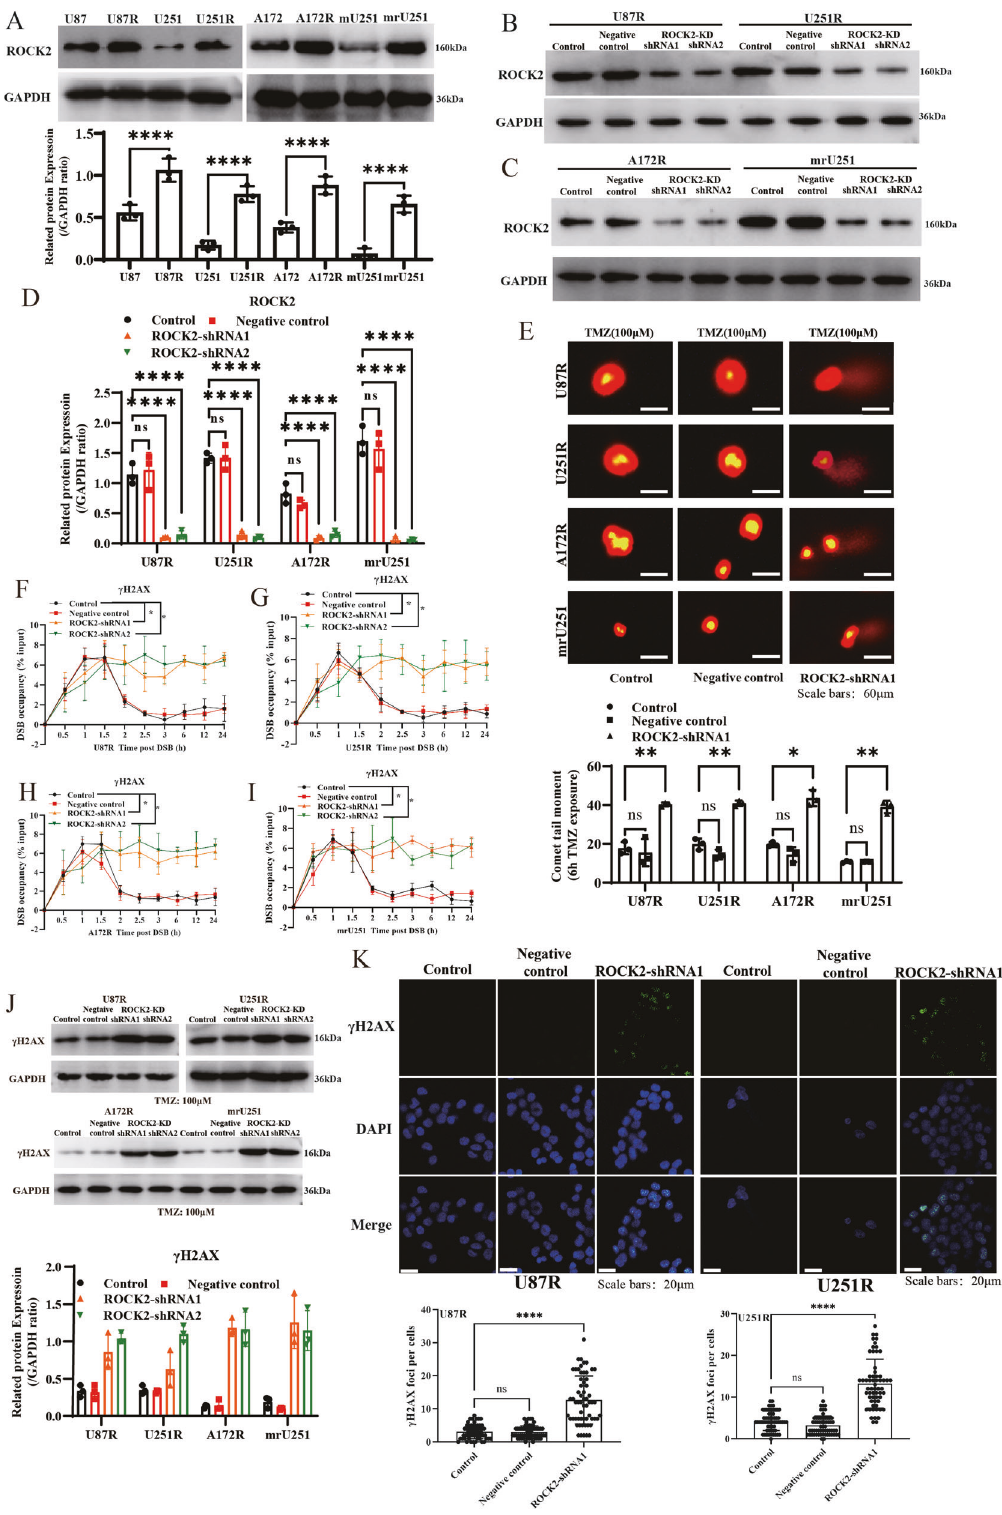
Fig. 2 ROCK2 suppression induced DSB in TMZ-R cells. A ROCK2 protein expression in TMZ-R cells and parental cells. B , C ROCK2 protein level was determined with ROCK2-shRNA (ROCK2-KD). D WB quanti fi cation of B and C . E Neutral comet assay was performed, Scale bars, p values determined by ANOVA or two-tailed unpaired t -test. Statistical differences compared with the controls are given as * p < 0.05, ** p < 0.01, *** p < 0.005, **** p < 0.001.